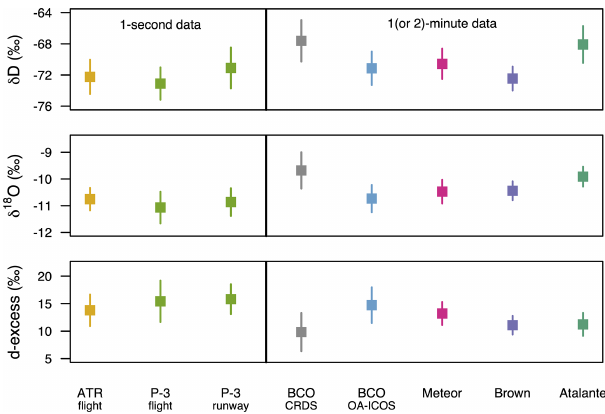
Figure 10. Campaign-mean near-surface water vapor isotopic val- ues from the various ground, airborne, and ship-based platforms. Whiskers represent standard deviations. Values from in flight rep- resent a height of 150 ± 15ma.s.l. With the exception of the BCO OA-ICOS measurements, only data that are not flagged for suspect quality are included in the